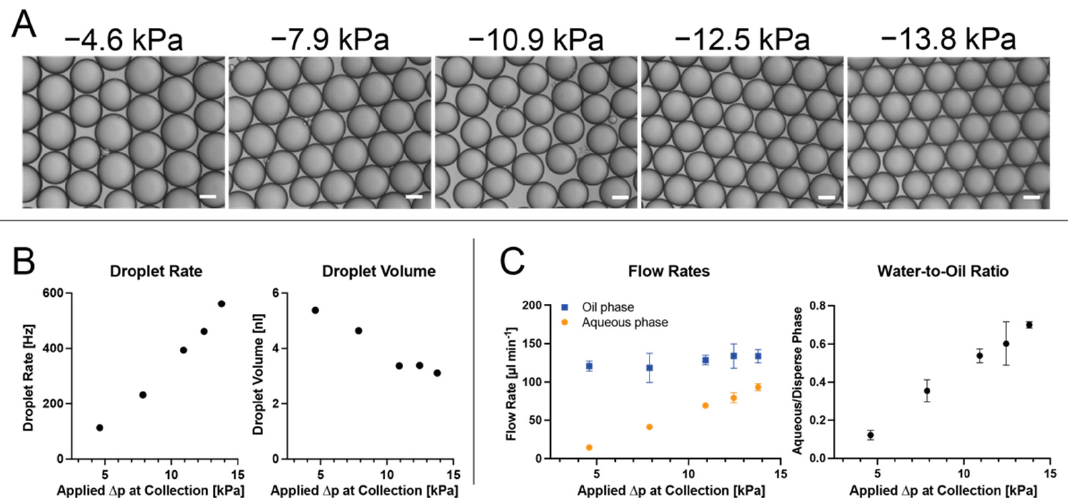
Figure 4. Single − Pump Droplet Generation. ( A ) shows representative images of the resulting emulsions at varying applied pressures at the collection outlet; the white scale bar denotes 100 µm. ( B ) shows droplet rate and volume, the flow rates for both phases, and the water − to − oil ratio for the tested pressures. Notably, the droplet rate increases faster than the droplet volume decreases. ( C ) depicts the flow rate measurements examined by weighing the output after 2 min of operation. Evidently, an increase in the applied negative pressure at the outlet predominantly increases the aqueous phase flow, resulting in an increase in the water − to − oil